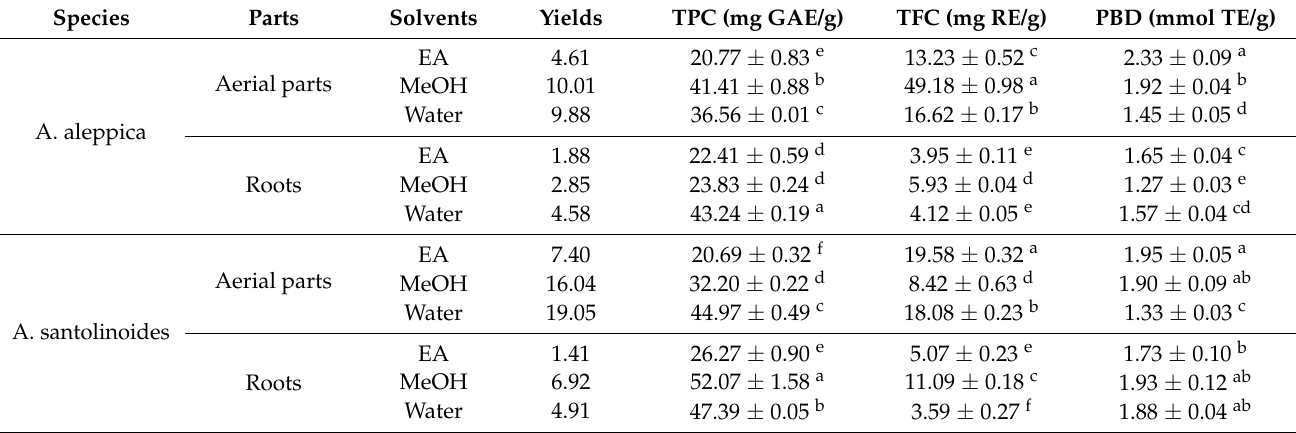
Table 1. Extraction yields (%), total bioactive compounds and total antioxidant capacity (by phosphomolybdenum assays) of the tested extracts *.